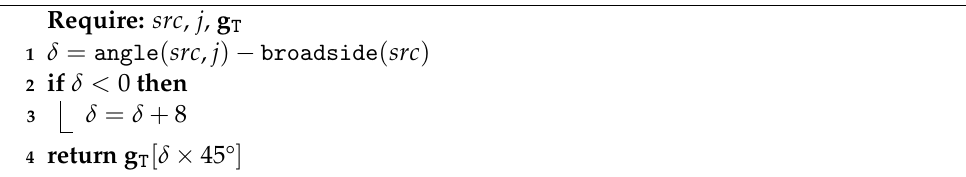
Algorithm A3 calculates the penalty for each direction change when Algorithm